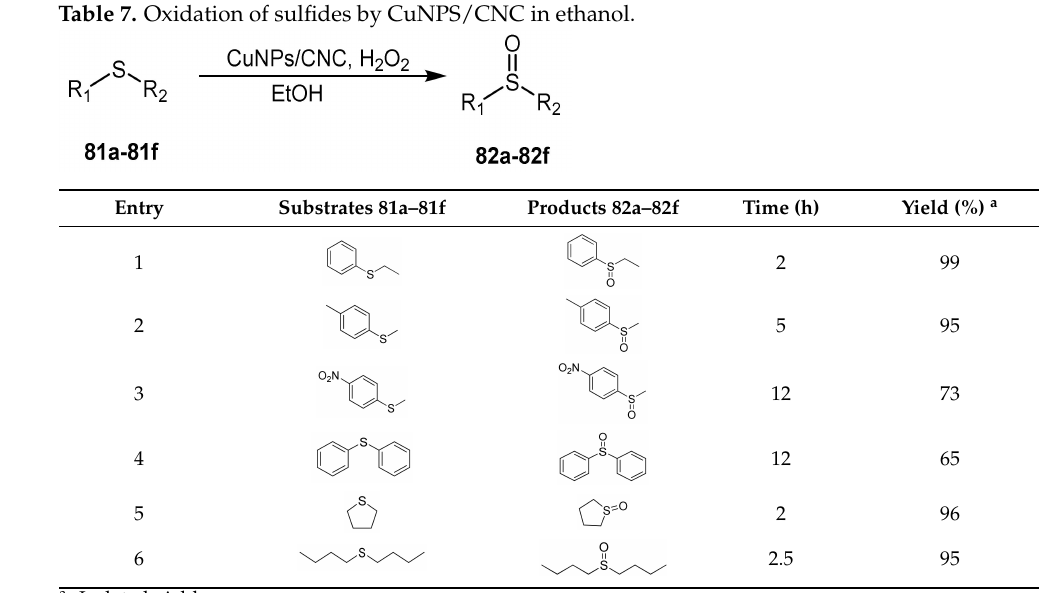
Table 7. Oxidation of sulfides by CuNPS/CNC in ethanol.